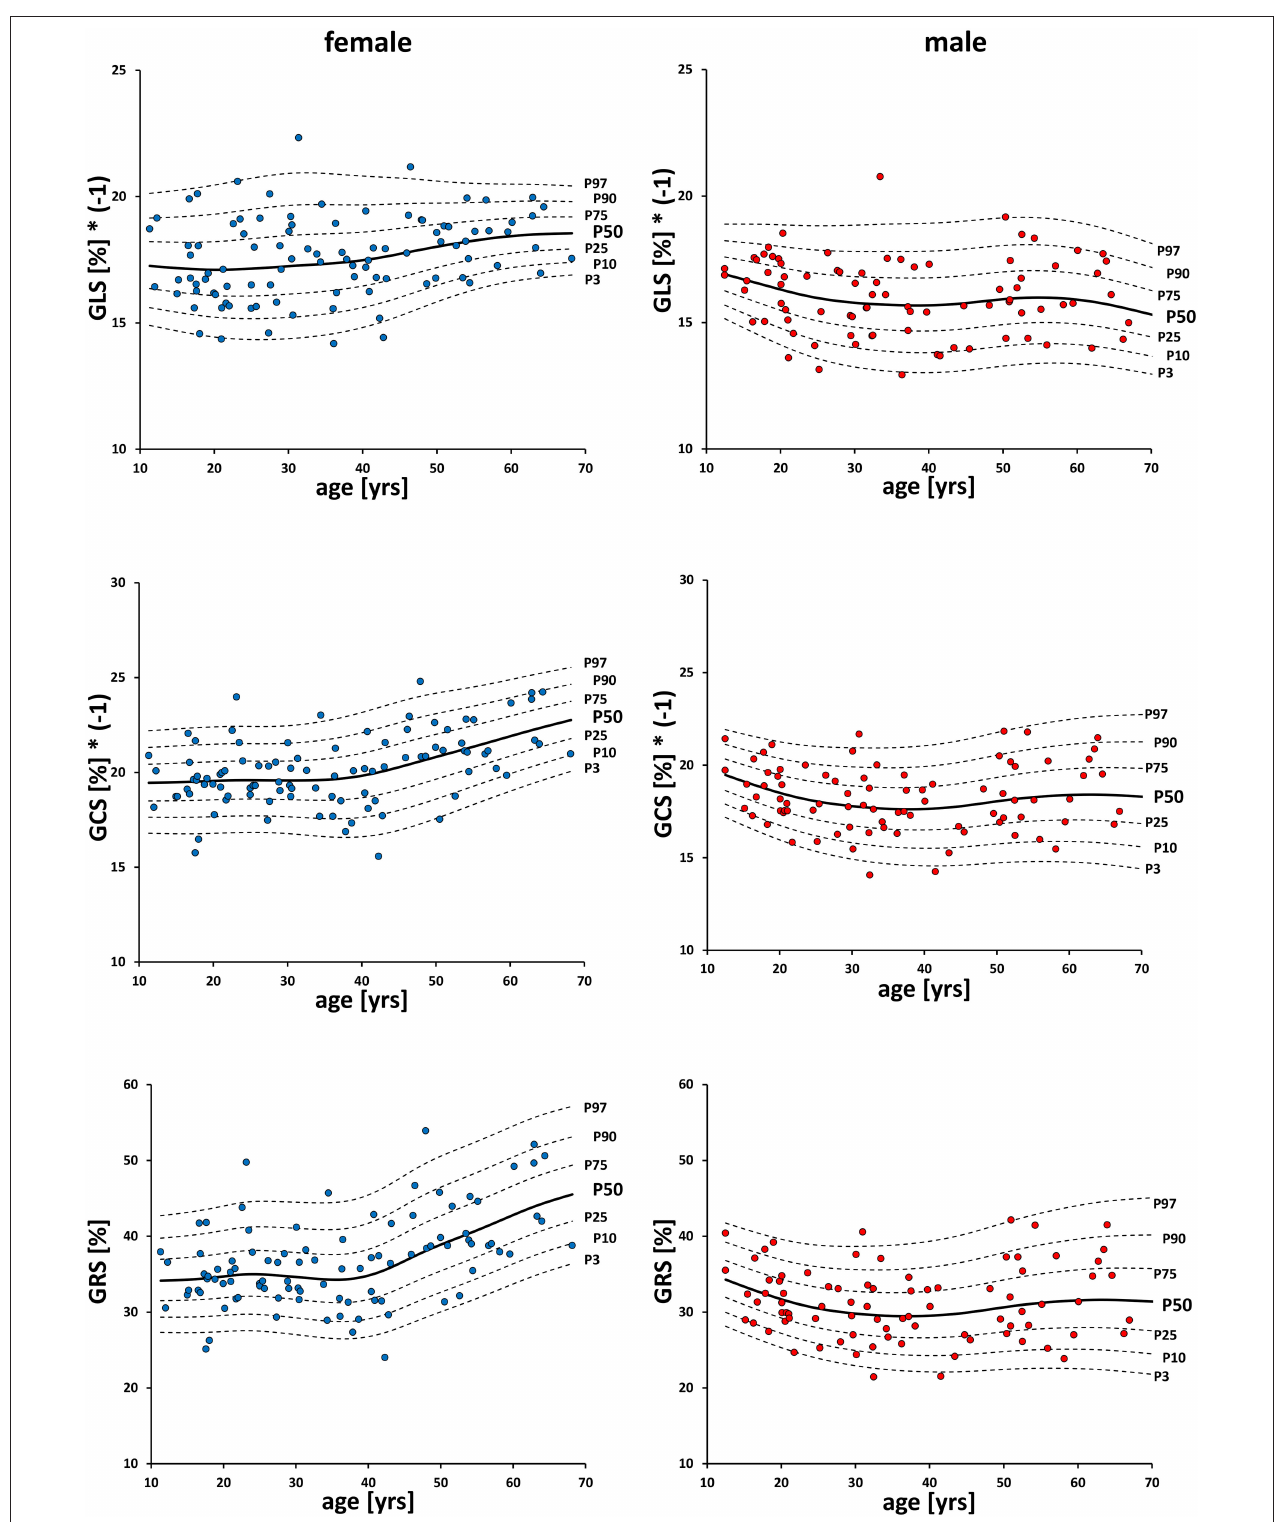
FIGURE 4 | Percentile-curves of global strain values by FT. GLS, global longitudinal strain; GCS, global circumferential strain; GRS global radial strain.